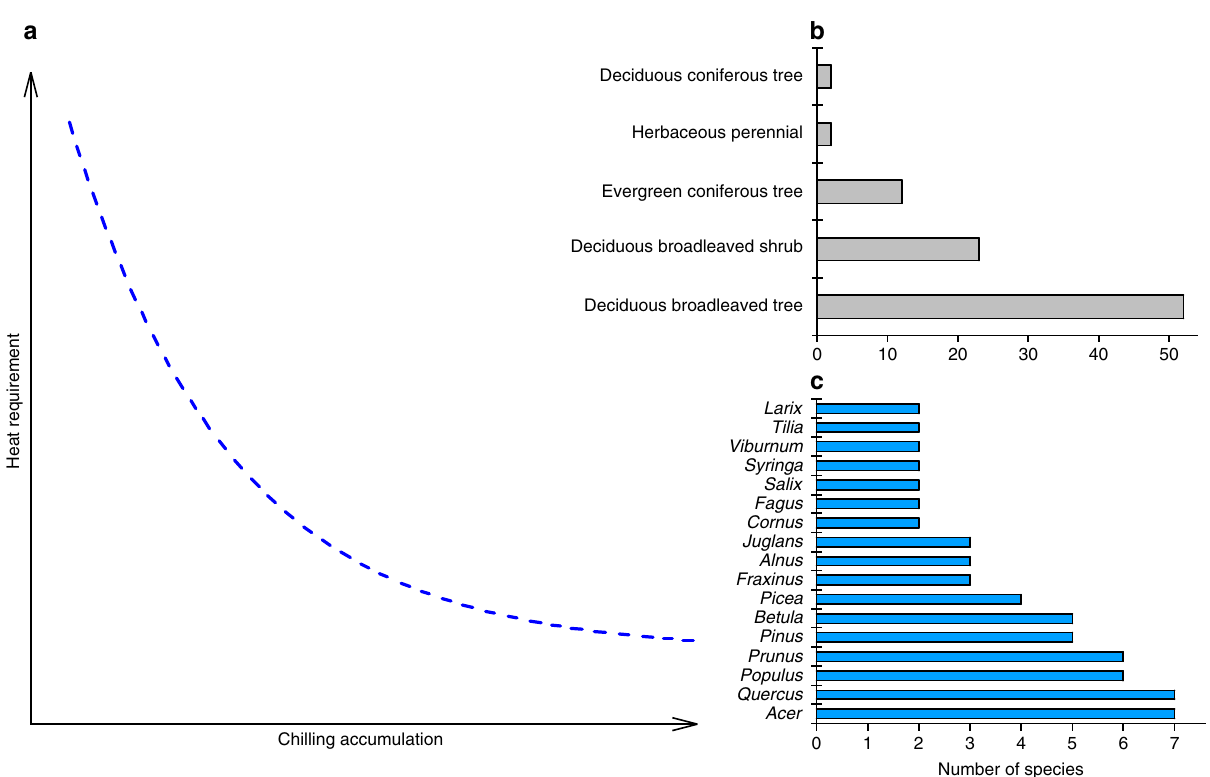
Fig. 1 Conceptual scheme of the relationship between HR and CA. Previous studies (Supplementary Table 1) found that saplings and twigs of 91 perennials need less heat for budburst (or leaf-out and fl owering) if they receive more or longer chilling in natural or controlled environments. a Chilling accumulation (CA) is linearly or nonlinearly (the fi gure only shows a nonlinear relationship) negatively correlated with heat requirement (HR). The subplot shows the number of species exhibiting such a relationship for each life form ( b ) and genus ( c ). The CA – HR relationships for each species are shown in Supplementary Fig. Fig. 10). Across different locations, the simulated mean date